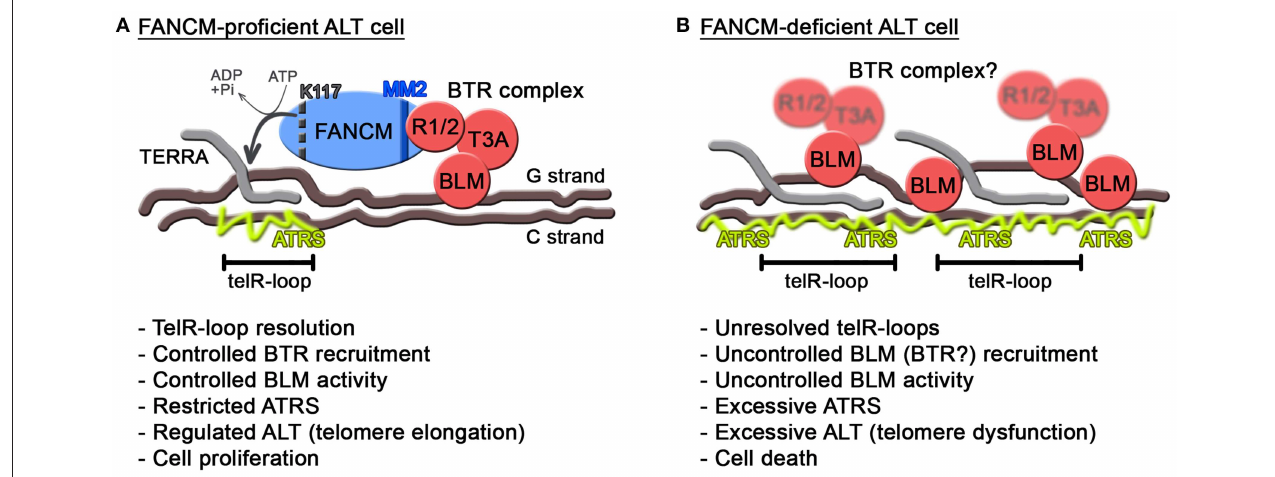
FIGURE 2 | Model for FANCM function at ALT telomeres. (A) In FANCM-proficient ALT cells, FANCM association with telomeric chromatin assures unwinding of harmful telR-loops through its ATPase activity. Additionally, FANCM interaction with RMI1/2 assures regulated recruitment and activity of BLM. In this situation, ATRS is maintained below toxic levels allowing telomere elongation and infinite cell proliferation. In FANCM, lysine K117 and the MM2 motif are indicated by a dotted black line and a blue line, respectively. (B) In FANCM-deficient ALT cells, telR-loops accumulate and BLM is aberrantly recruited and activated, leading to excessive ATRS and eventually cell death. RMI1/2 and TOP3A are blurred to indicate that their recruitment to telomeres has not been tested yet in FANCM-deficient cells.